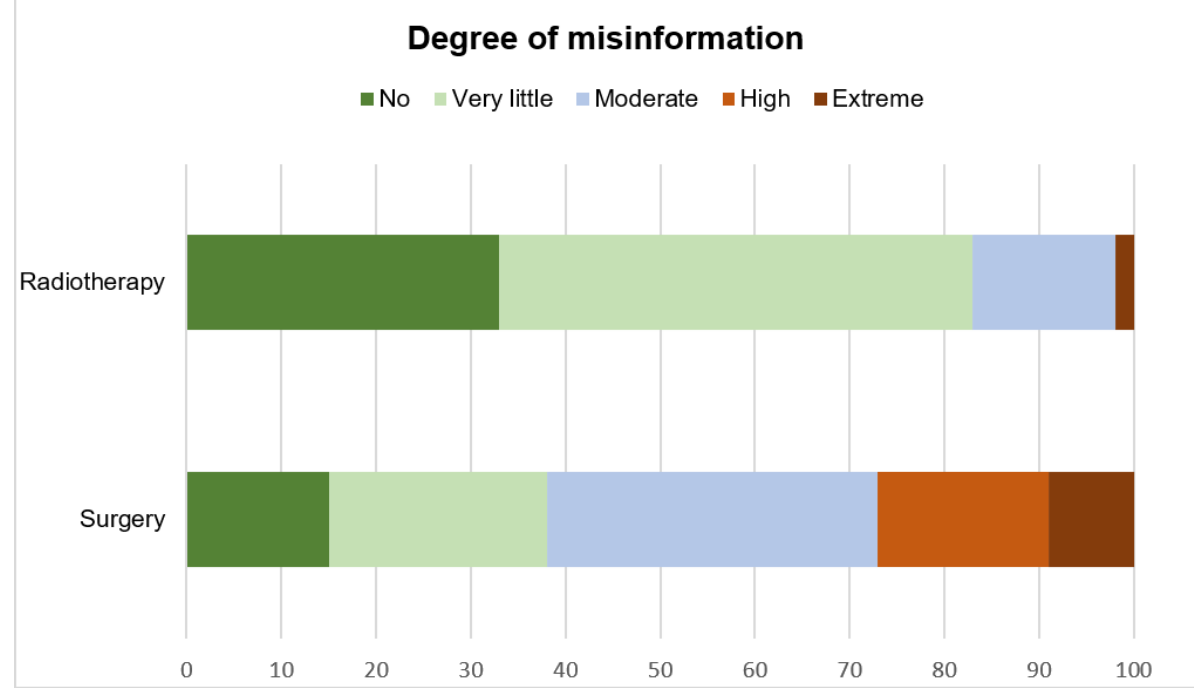
Figure 2. Degree of misinformation (percent, x-axis) compared to currently available evidence (no: green; very little: light green; moderate: light blue; high: light red; extreme: dark red).